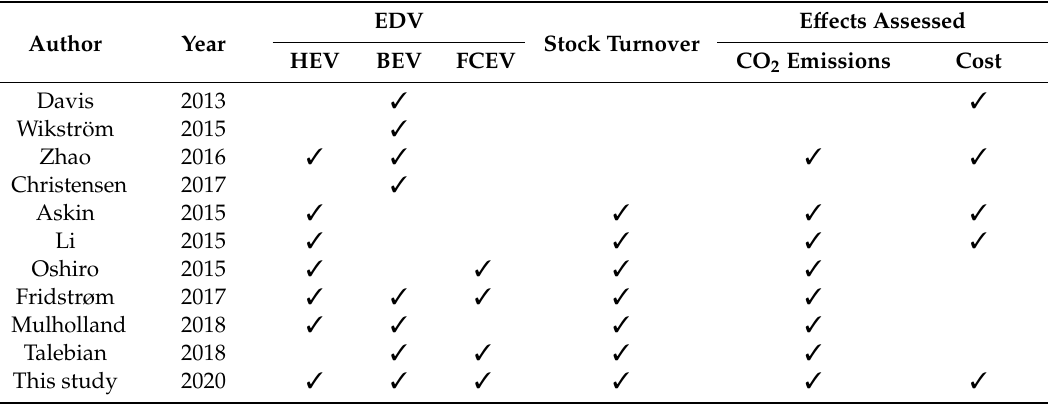
Table 1. Main characteristics of previous studies regarding powertrain electrification in road freight transport on a fleet